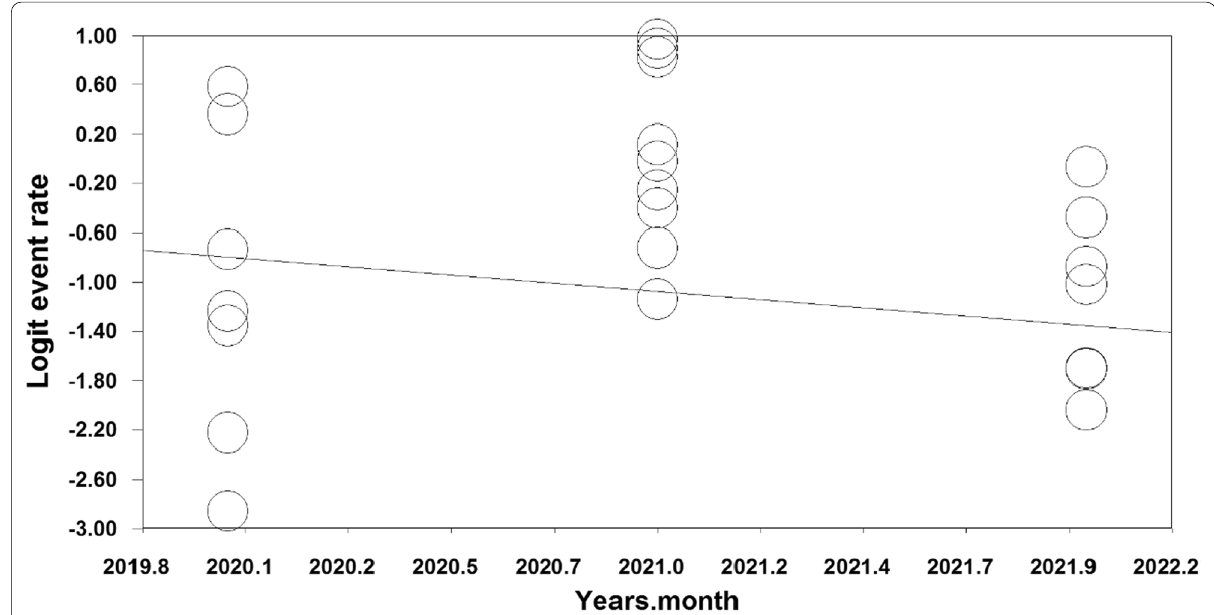
Fig. 4 Meta‑regression diagram of the prevalence of polypharmacy in patients with COVID‑19 by year of study (month)